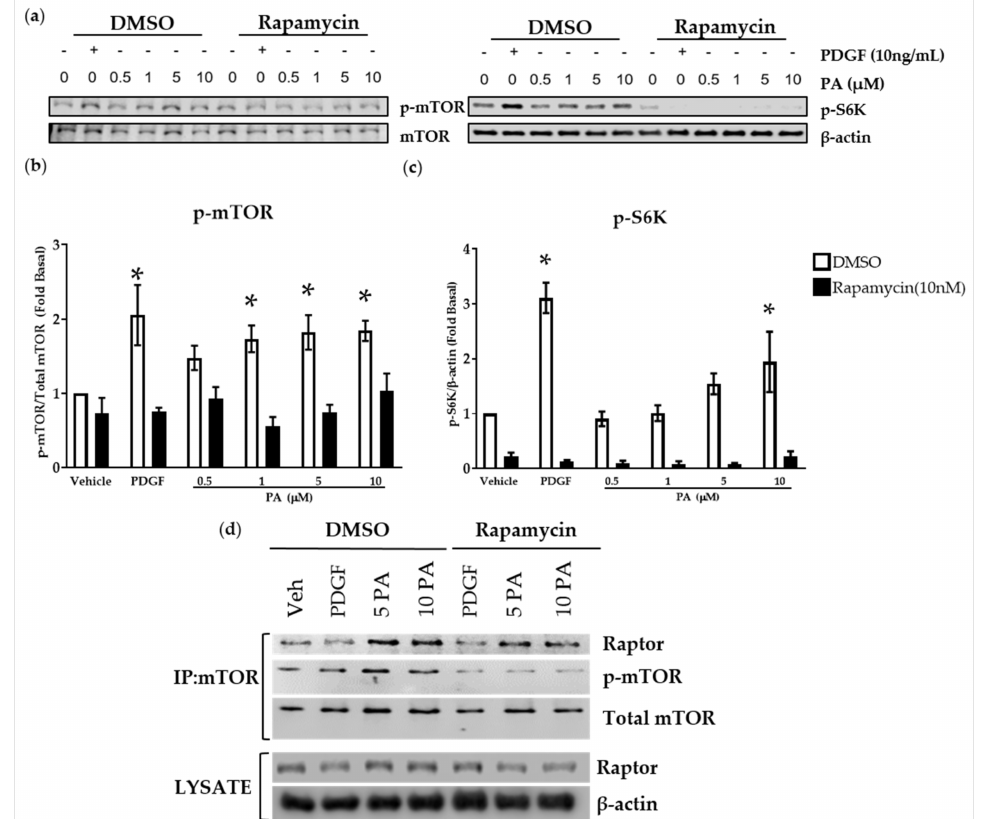
Figure 5. Effect of PA on the formation of mTOR complex 1. Human ASM cells were treated with DMSO or rapamycin (10 nM) for 10 min followed by stimulation with vehicle, PDGF (10 ng/mL), or PA (0.5 µ M–10 µ M). Cells were lysed and immunoblotted for ( a , b ) p-mTOR; ( a , b ) total mTOR; ( a , c ) p-S6K; and ( a , c ) β -actin. Graphical representation of mean ± SEM of the ( b ) p-mTOR and ( c ) p-S6K densitometry data from blots normalized to basal condition. hTERT ASM cells were treated with DMSO or rapamycin (10 nM) for 10 min followed by stimulation with PDGF (10 ng/mL), or PA (5 µ M or 10 µ M) for 20 min. Cells were lysed and immunoprecipitated using a total mTOR antibody. ( d ) Lysates and immunoprecipitates were immunoblotted for raptor, p-mTOR, mTOR, and β -actin. ( a – c ) Data above are representative from n = 4–7 independent donors and ( d ) n = 3 independent experiments. * p < 0.05 compared to vehicle using one-way ANOVA with Bonferroni post-hoc